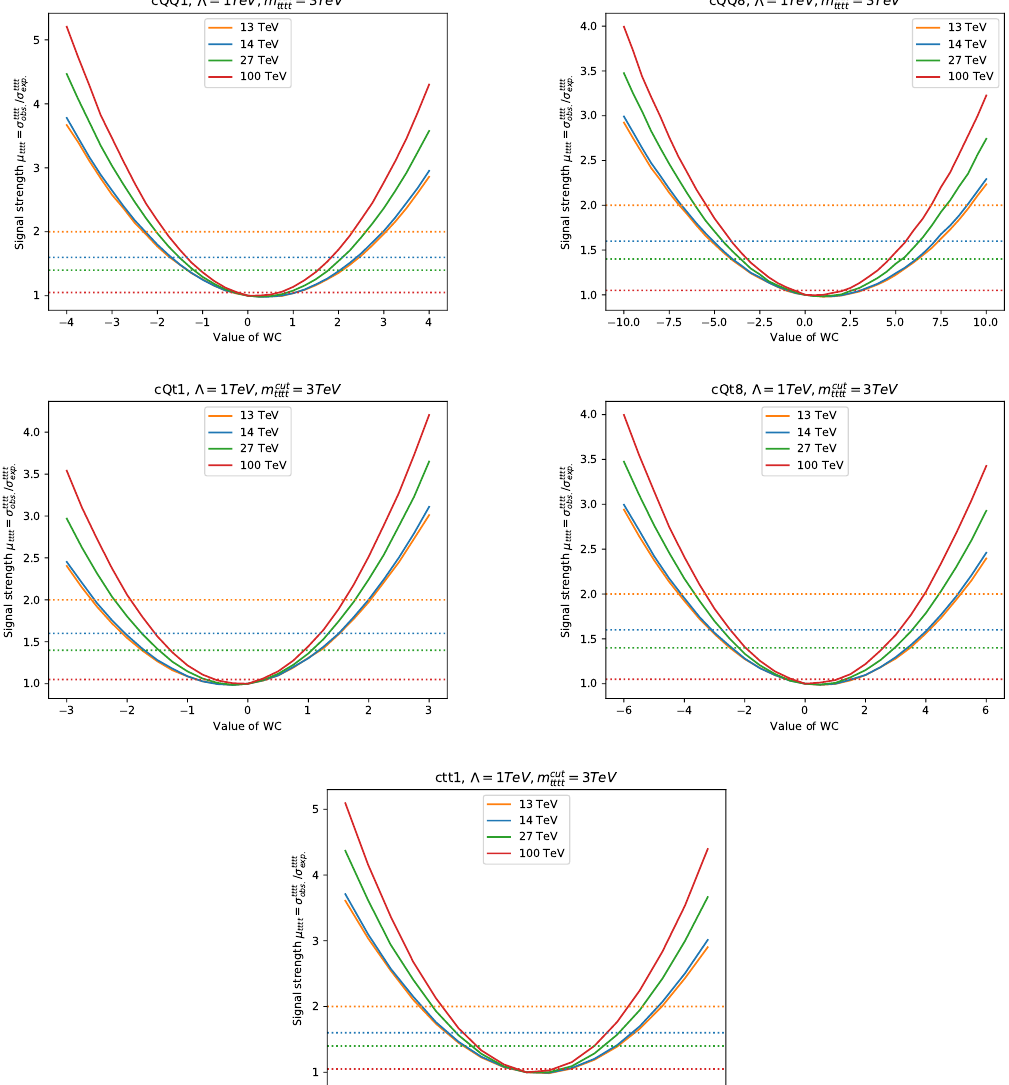
Figure 15 . Four-top production signal strength as a function of the WC values for all the 4-heavy operators. The EFT predictions include both linear interference and quadratic contributions. The horizontal lines represent the expected measurement at each collision energy derived from the expected total